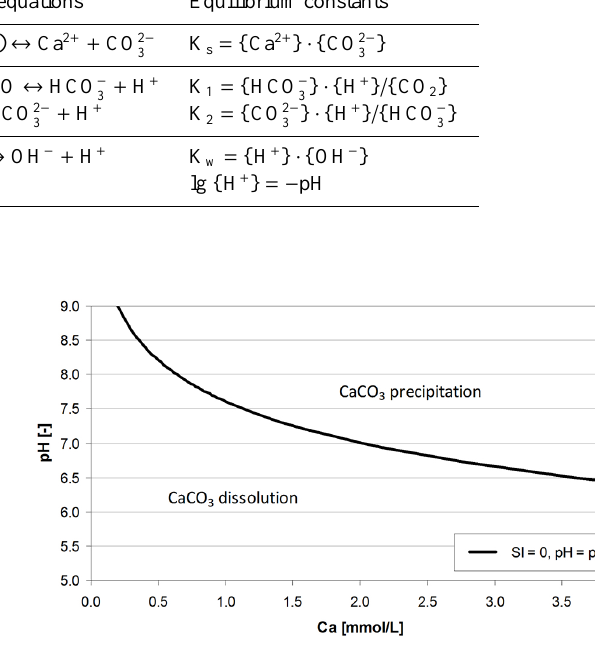
Table 1. Processes generally used for description of calcium carbonate (CaCO 3 ) saturation in drinking water. Part